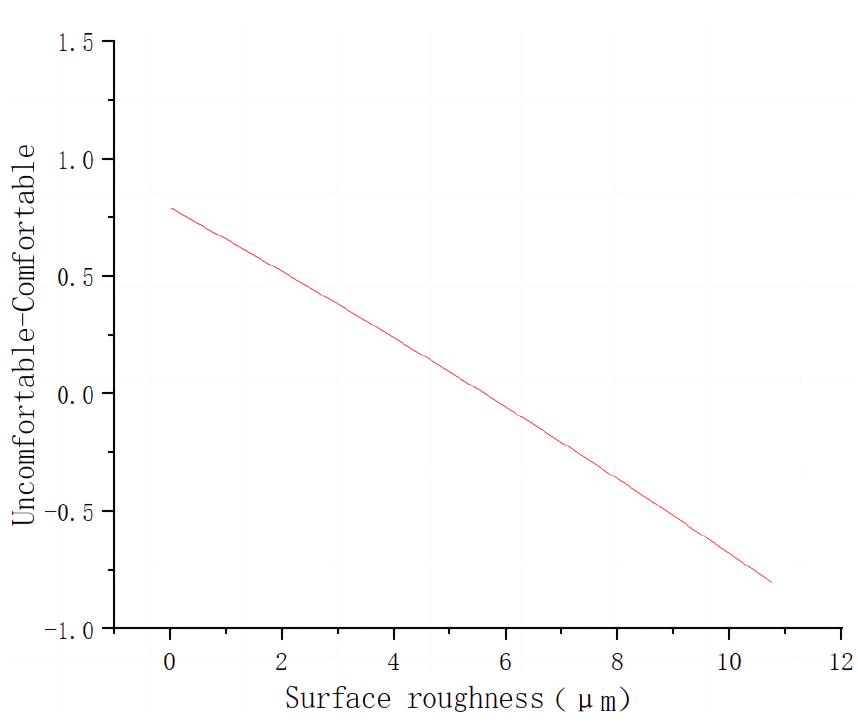
Figure 13. “Uncomfortable-Comfortable” and Surface roughness polynomial fitting function.